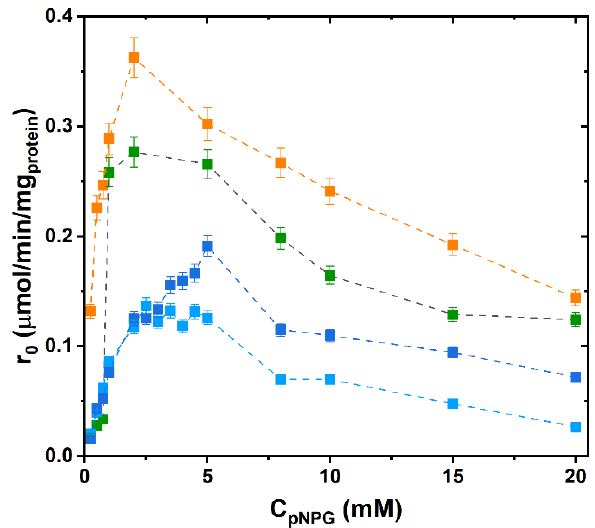
Figure 1. Dependency of the initial rate of pNPG hydrolysis upon substrate concentration variation for different β− glucosidase catalysts. Free enzyme (green) and immobilized enzyme: Ag ‐ PEI 2000 for different β -glucosidase catalysts. Free enzyme (green) and immobilized enzyme: Ag-PEI 2000 U _pNPG /g support (orange), Ag ‐ Gly 200 U _pNPG /g support (light blue) and Ag ‐ Gly 2000 U _pNPG /g support (dark U _pNPG /g support (orange), Ag-Gly 200 U _pNPG /g support (light blue) and Ag-Gly 2000 U _pNPG /g support blue). The data shown are representative of the multiple experiments repeated. (dark blue). The data shown are representative of the multiple experiments